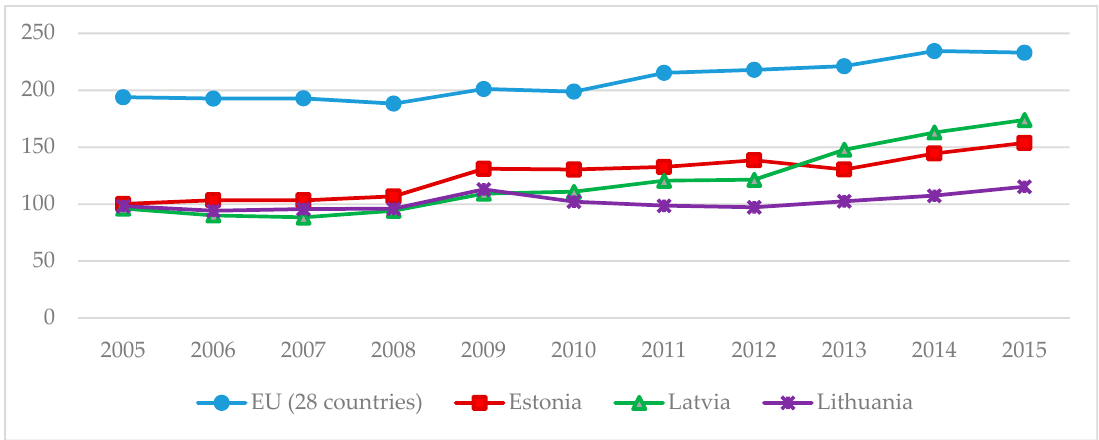
Figure 5. Implicit energy tax rate in the Baltic States, EUR per ton of oil equivalent.